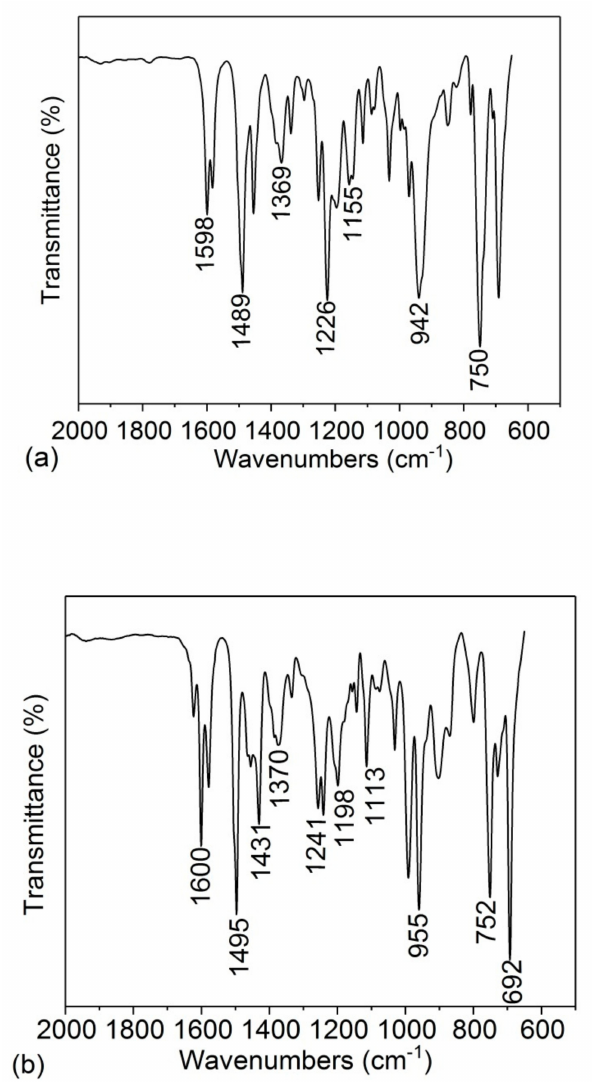
Figure 2. The FTIR of ( a ) aniline-phenol type benzoxazine and ( b ) aniline-cardanol type